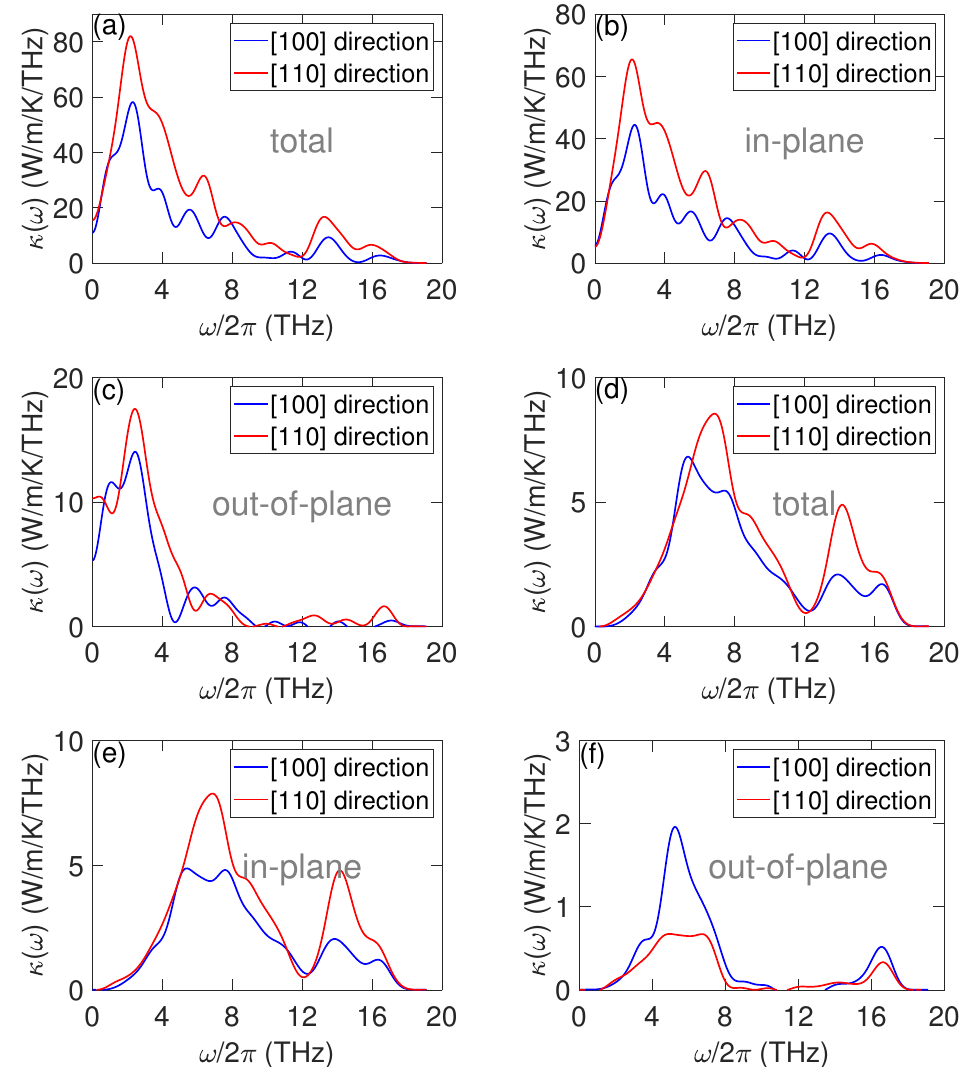
Figure 4. Spectrally decomposed TC for the pristine and resonant membranes. Total ( a ), in-plane ( b ) and out-of-plane ( c ) STC along the [100] and [110] crystallographic directions of the pristine membranes. Total ( d ), in-plane ( e ) and out-of-plane ( f ) STC along the [100] and [110] crystallographic directions of the resonant